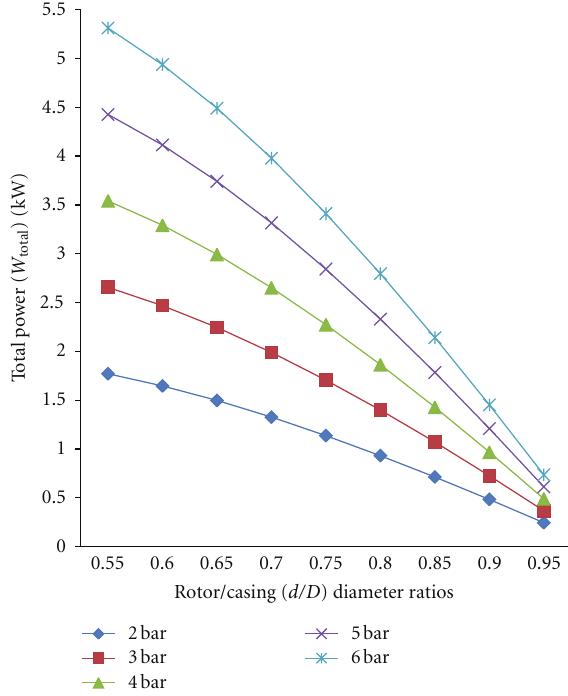
Figure 7: Total power output versus rotor/casing diameter ( d/D ) ratio when D = 100